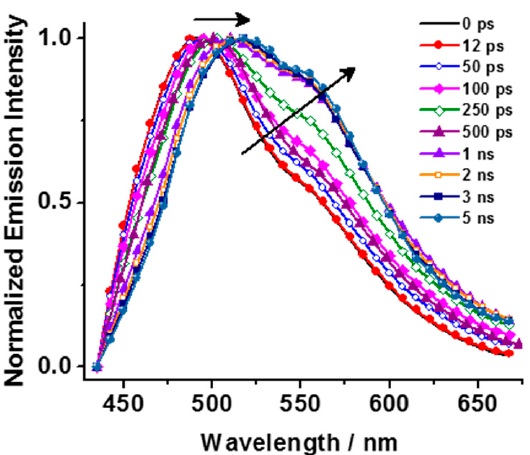
Figure 4. Normalized TRES of DCM interacting with HY zeolite prepared from a 1 × 10 − 3 M initial dye solution, gated at the indicated delay times after excitation at 371 nm.